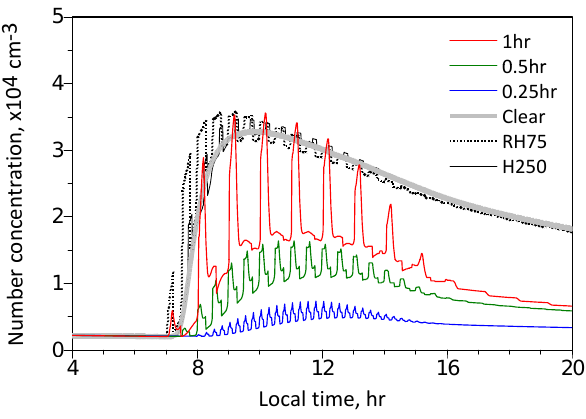
Fig. 12. Same as the reference run (green curve) in Fig. 11 but for turbulence eddies with varying vertical amplitudes. The light- dashed curve is along the parcel trajectory, and the solid dots are near surface